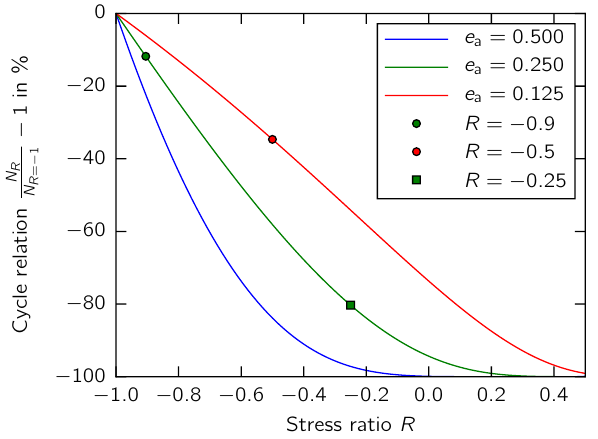
Figure 9. Impact of stress ratio on the relation between allowable cycles using any testing stress ratio and a stress ratio of R = − 1 (Eq. 6) shown for different stress exposure amplitudes. An S–N curve exponent of m = 10 was